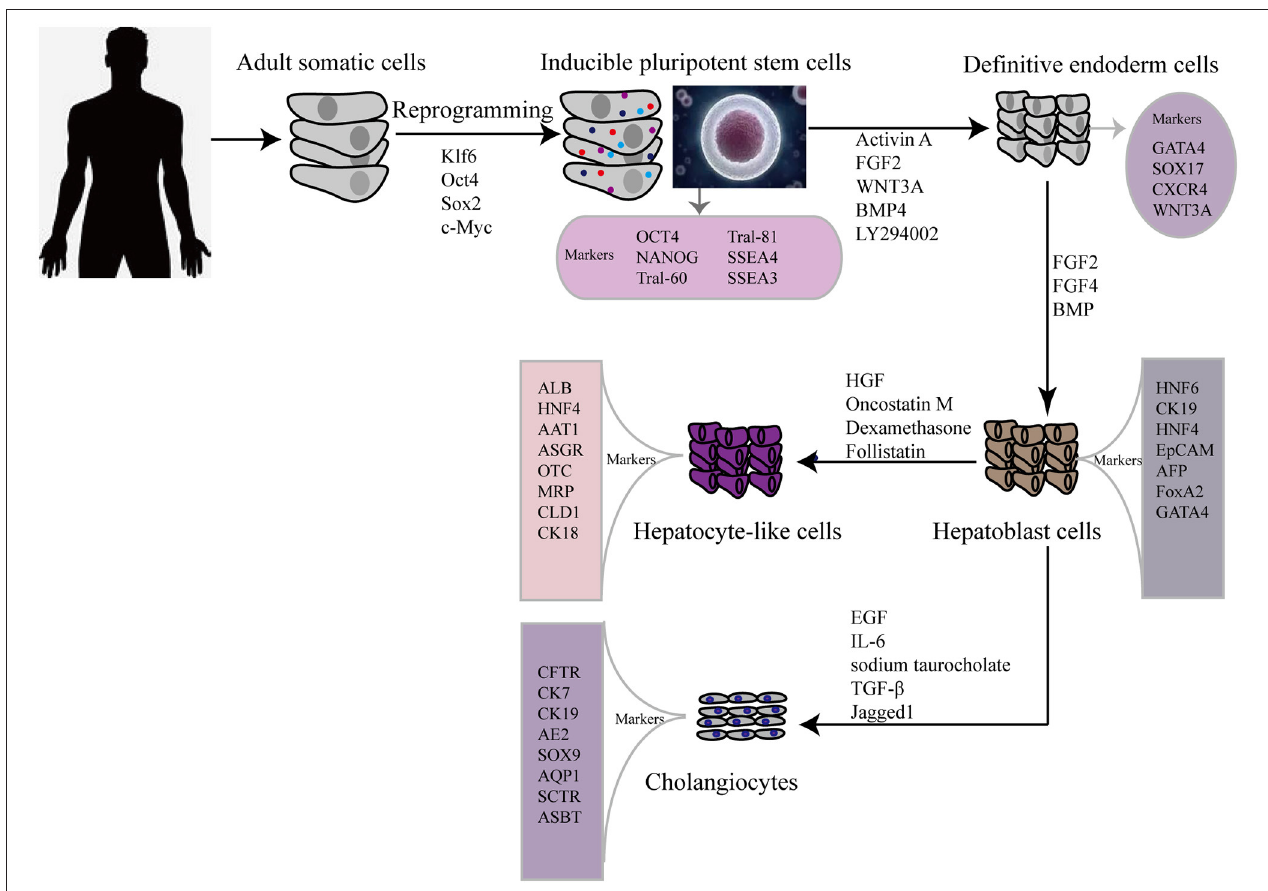
FIGURE 1 | Flow diagram showing typical protocol for iPSCs reprogramming and hepatic differentiation of human into hepatocyte-like cells in vitro . OCT 4, octamer binding transcription factor 3/4; SSEA, stage-specific embryonic antigen; TRA, Tumor resistance antigen 1-60; SOX2 sex determining region Y box 2; KLF4 (Kruppel-like factor 4); GATA4, GATA binding protein 4; CXCR4, C-X-C chemokine receptor type 4; FGF, fibroblast growth factor; HGF, hepatocyte growth factor; BMP, bone morphogenetic protein; HNF6, Hepatocyte nuclear factor 6; CK, cytokeratin; EpCAM, Epithelial cell adhesion molecule; AFP, alpha-fetoprotein; AAT1, α 1-anti-tripsin; ALB, albumin; ASGR, asialoglycoprotein receptor; MRP, multidrug resistance protein; CLD, claudin; EGF, epidermal growth factor; IL-6, interleukin 6; TGF- β , transforming growth factor beta; CK7, cytokeratin 7; CK19, cytokeratin 19; AE2, chloride/bicarbonate anion exchanger 2; ASBT, apical sodium-dependent bile acid transporter; CFTR, cystic fibrosis transmembrane conductance regulator; AQP1, aquaporin-1; SOX9, SRY-box 9; SCTR, secretin receptor.